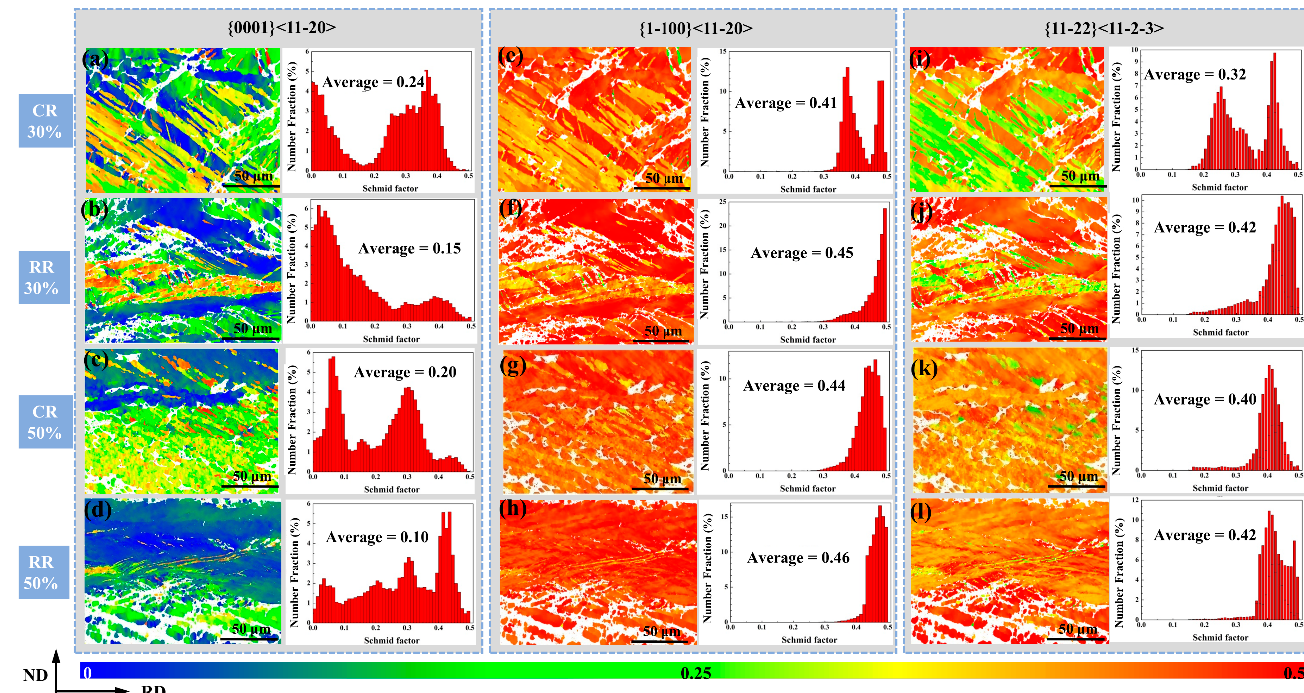
Figure 9. The Schmidt factor value of ( a , e , i ) CR30%, ( b , f , j ) CR50%, ( c , g , k ) RR30%, and ( d , h , l ) RR50% plates. The Schmidt factor value of the basal slip under conventional rolling is higher than that of the restricted rolling because the straight and slender compression twins have a larger Schmidt factor of basal slip. The slip of the base surface cannot coordinate the deformation of the c-axis, thus it cannot effectively coordinate the deformation and suppress the occurrence of cracks. The Schmidt factor values of prismatic slip and pyramidal slip